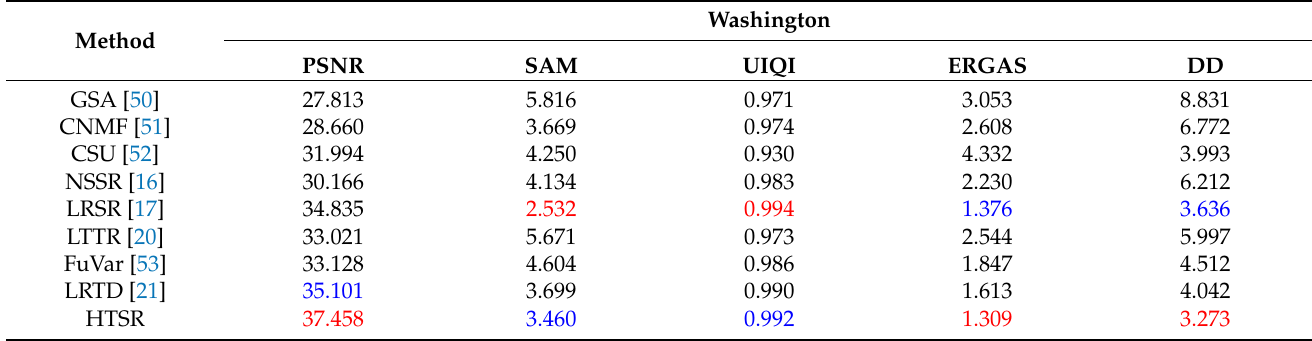
Table 3. Quantitative metrics of the competitive methods on the Washington DC Wall dataset.